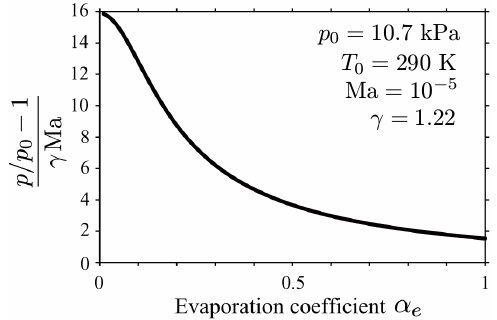
Fig. 3 Relation between the evaporation coefficient and pressure amplitude for methanol (linear analysis). The is initial saturated vapor pressure, the is initial vapor temperature and the is Mach